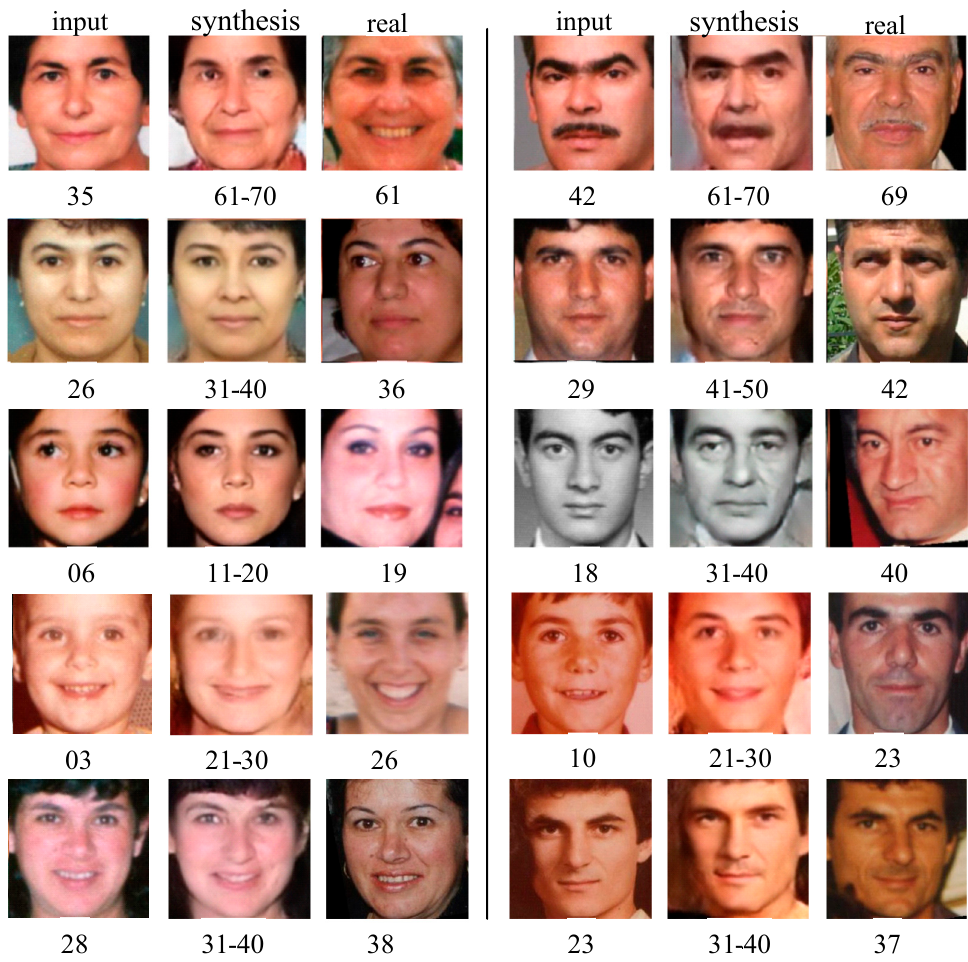
Figure 11. Compared with the real image to judge authenticity.